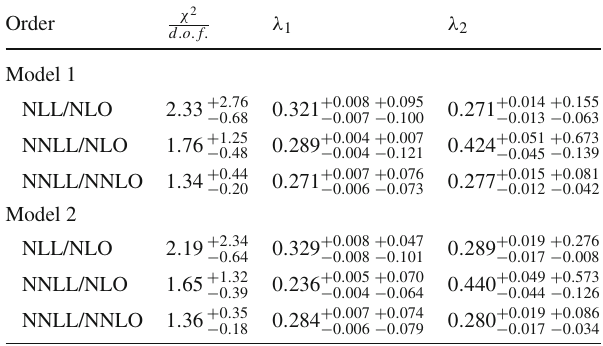
Table 12 The results of the χ 2 -minimization procedure with g K = 0. The values of χ 2 are given including the theoretical error-band. The values of extracted parameters are given with statistical error-band (the first pair of numbers) and the theoretical error-band (the second pair of numbers). The visual presentation of this table is given in Fig.9